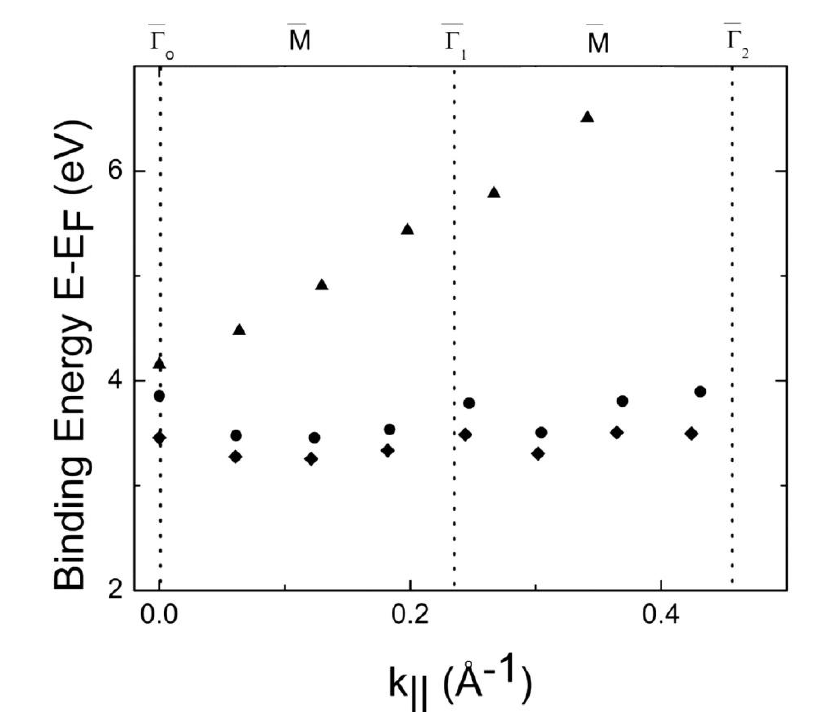
Figure 3. The unoccupied state binding energies versus the surface parallel wave vector are mapped for the Li B O (110) along the [110] direction. (♦) denotes the 2 4 7 lowest unoccupied molecular orbital, (●) a higher energy empty state, and (▲) an image state. The surface Brillouin zone critical points are denoted at top. Adapted from